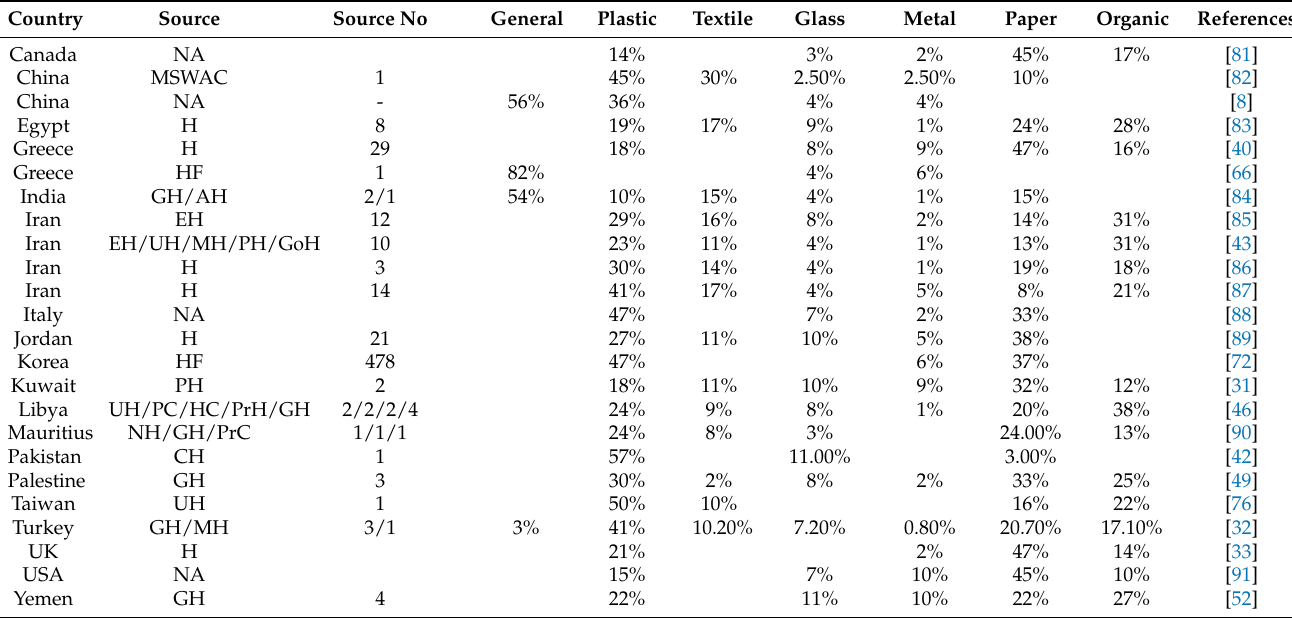
Table 3. Medical waste fractions’